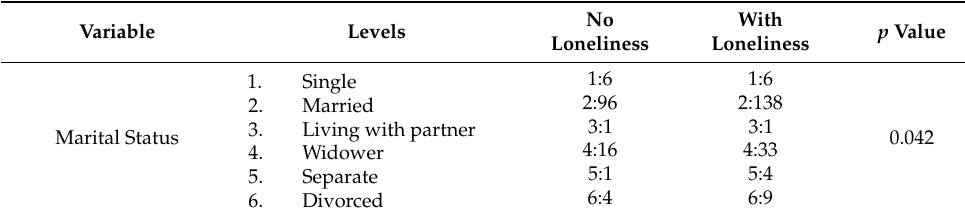
Table 1. Comparisons of means or counts and standard deviation, and p -value. Only those compar- isons that are statistically significant ( p ≤ 0.05) are collected. Variable